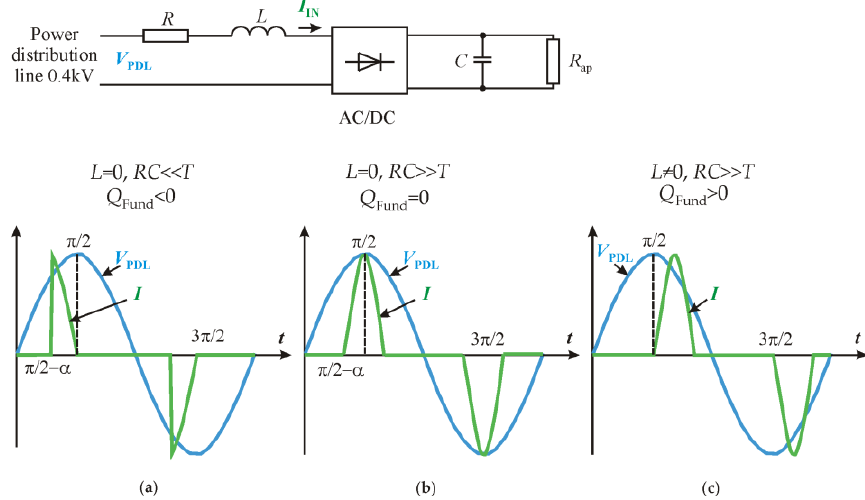
Figure 4. Operation modes of VFD from point of view of the input reactive power [2]: ( a ) leading; ( b ) zero; ( c ) lagging.